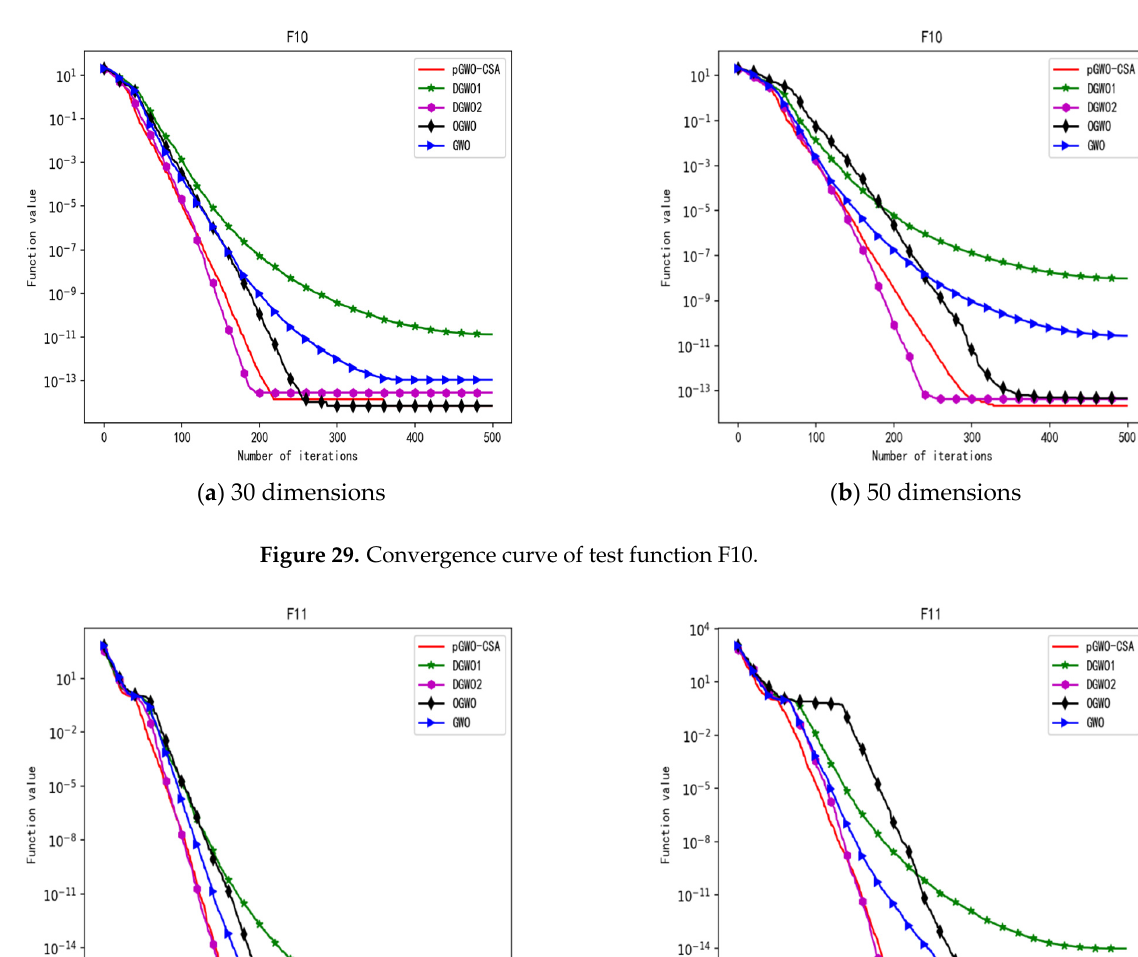
Figure 28. Convergence curve of test function F9.